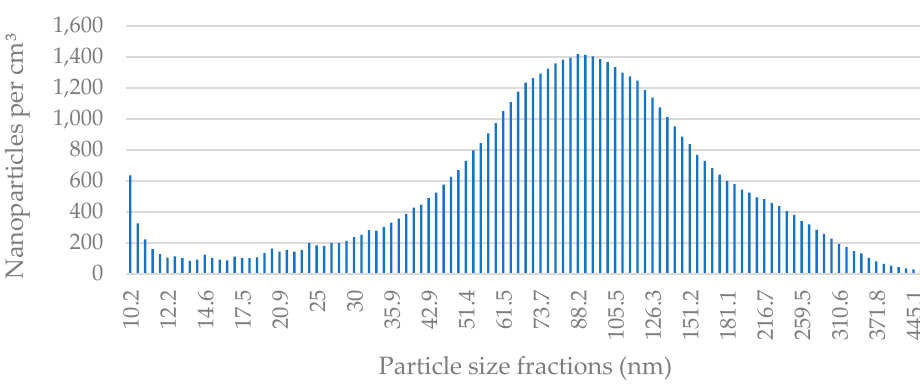
Figure A20. The average nanoparticle concentration in each size fraction in Building 10 during a one-week measurement period during the nonheating season.